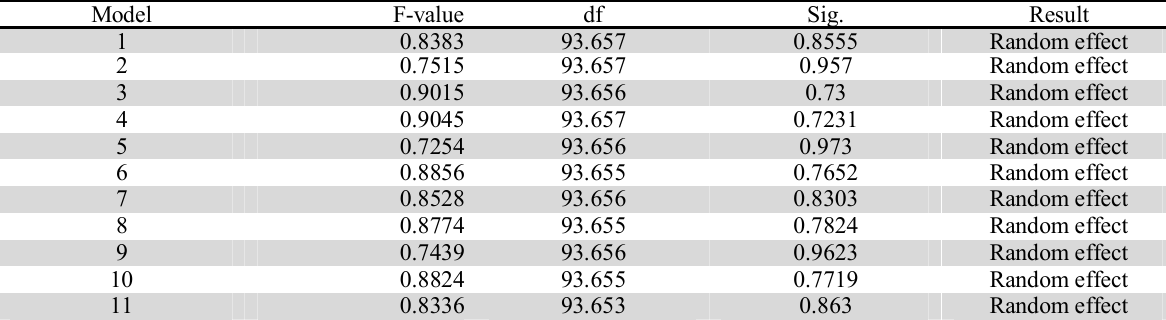
The summary of testing fixed/random effect